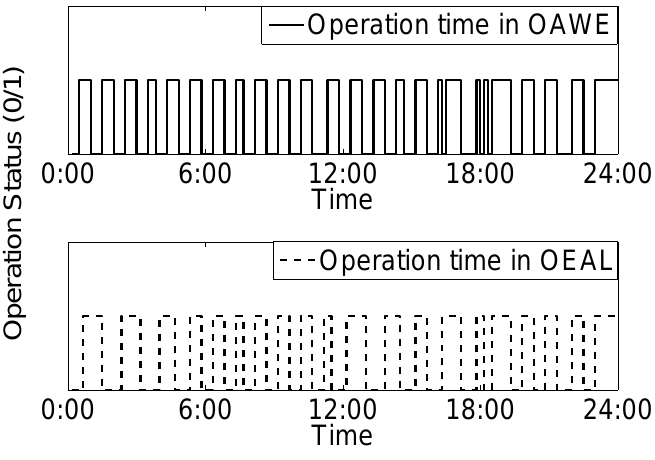
Figure 13. Comparison of the operation time for EWH between OAWE and